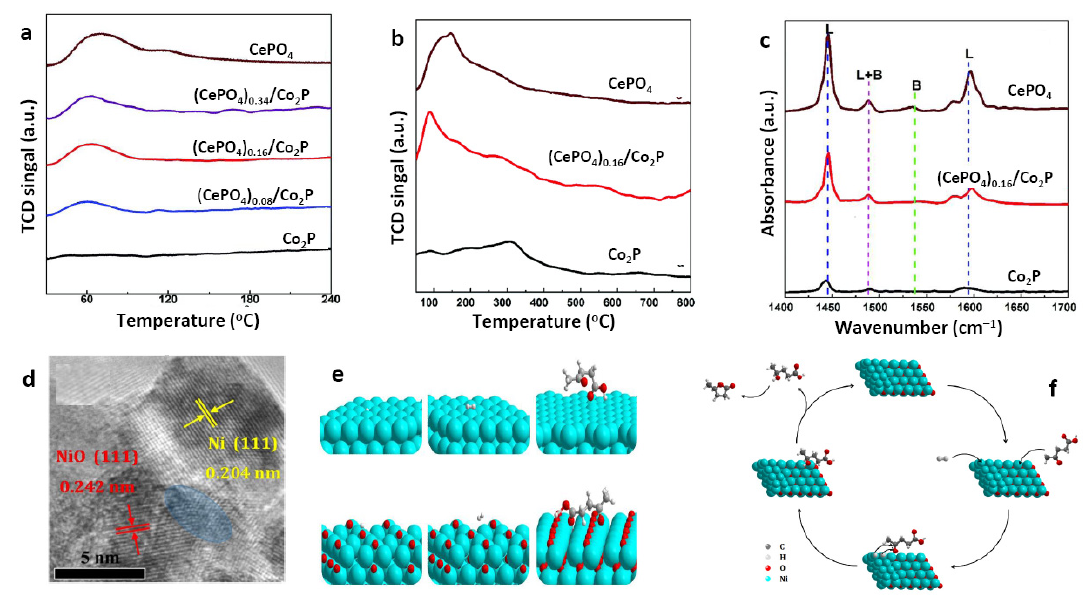
Figure 9. ( a ) H 2 -TPD profiles of catalysts. ( b ) NH 3 -TPD profiles of catalysts. ( c ) Pyridine (adsorbed) FT-IR spectra of catalysts (L: Lewis acid feature, B: Brønsted acid nature). Reproduced with permission from Reference [42]. Copyright 2013, Royal Society of Chemistry. ( d ) HRTEM image of NiO-523. ( e ) Structure models for H, H 2 and LA adsorption on Ni (111) and NiO (111). ( f ) Proposed mechanism for the hydrogenation of LA to GVL on Ni/NiO. Reproduced with permission from Reference